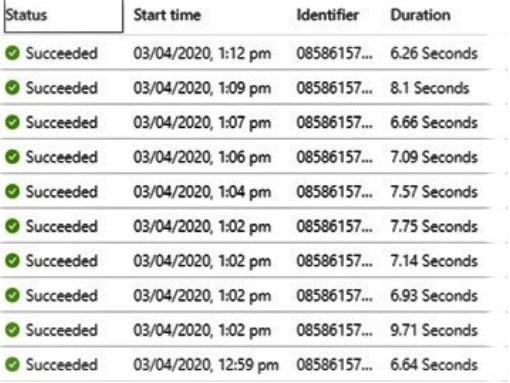
Figure 24. Duration for email notification alert.